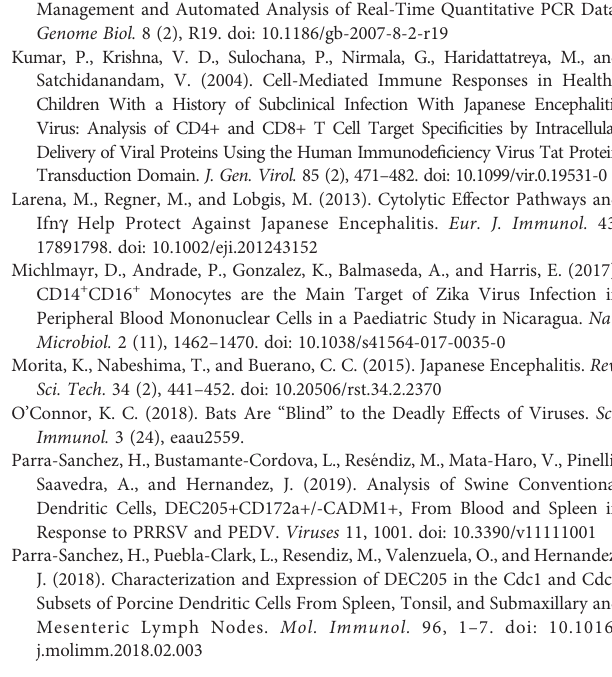
Supplementary Figure 1 | Gating strategy for lymphocytes detection in the blood. Lymphocytes were gated according to their light scatter properties. Staining for CD3 is a fi rst step in differentiating T cells from NK cells since T cells are characterized bythe expressionofCD3andNKcellsbythe lackofCD3expression. NK cells were then further gated on the expression of CD16 and CD8 and T cell subpopulations were discriminated by gating on gd TCR or CD4 and CD8 expression. The same strategy was used for determining these subsets among tonsil lymphocytes. Supplementary Figure 2 | Detection of cell-mediated immune responses upon in vitro stimulation of PBMCs from non-infected animals with NS3 antigen. (A) no proliferation can be observed in CD4 + CD8 + double-positive T cells, CD8 + T cells and gd T cells (B) nor can any IFN g production be observed in CD4 + CD8 + double- positive T cells, CD8 + T cells and NK cells upon restimulation with NS3 antigen of PBMCs from non-infected